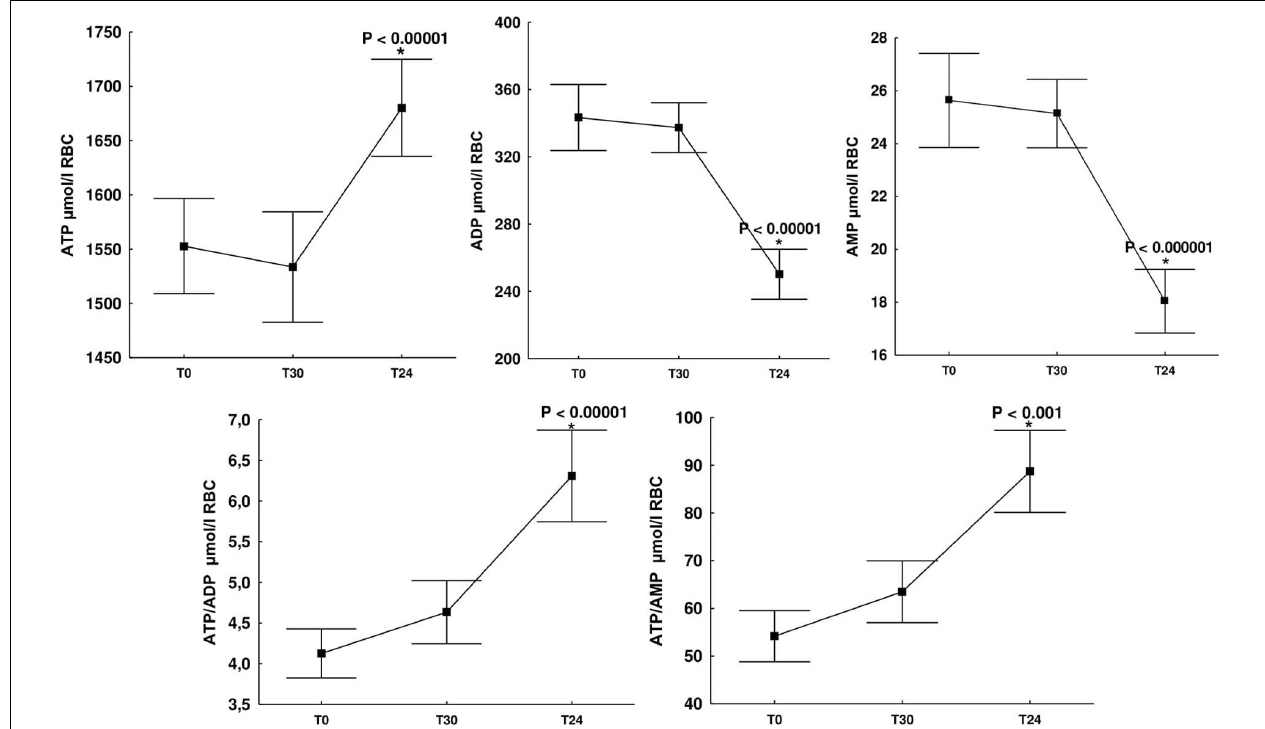
FIGURE 1 | Change in adenine nucleotide concentrations (ATP, ADP, and AMP), ATP/ADP, ATP/AMP ratios in erythrocytes of healthy subjects at rest (T0), 30 min after cryostimulation (T30), in the morning the day after (T24). ATP, adenosine-5 (cid:48) -triphosphate; ADP, adenosine-5 (cid:48) -diphosphate; AMP, adenosine-5 (cid:48) -monophosphate. Values are given as means ± SD. *Significant difference between rest (T0) and 30 min after cryostimulation (T30).